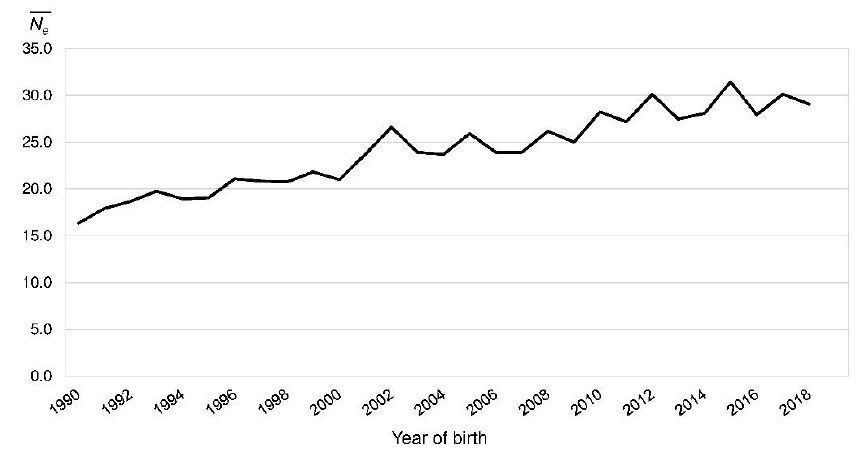
Figure 4. Realized effective population size ( 𝑁 𝑒 ) by the year of birth of the Polish Lowland Sheepdog reference population.